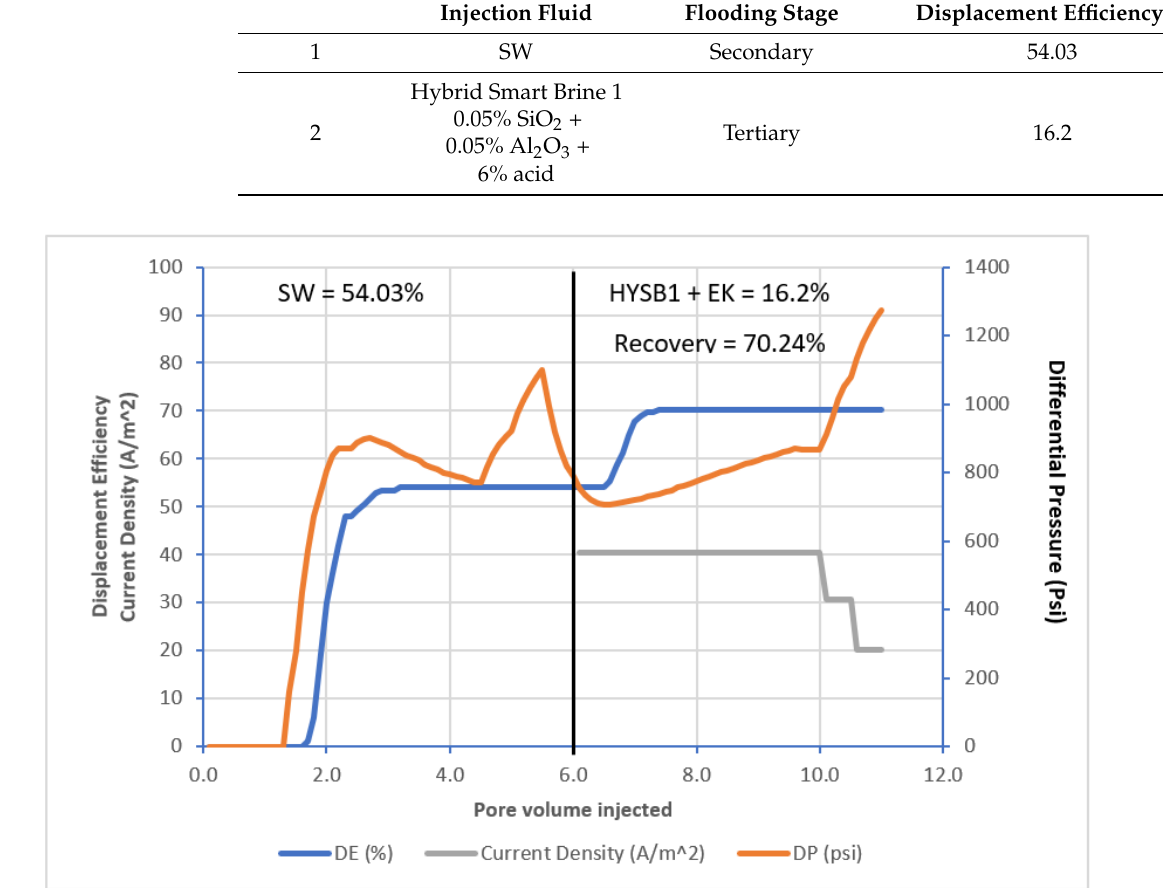
Figure 11. DE, DP ( ∆ P), Current Density vs. Pore Volume Injected for CF9. Figure 11. DE, DP (ΔP), Current Density vs. Pore Volume Injected for CF9.